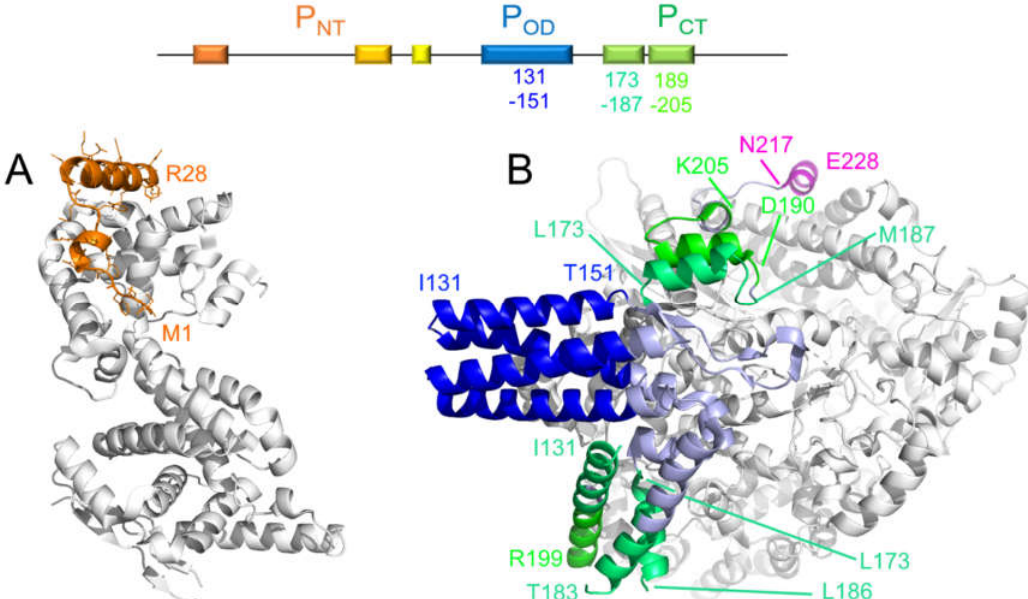
Figure 6. Folding of Pneumoviridae P protein upon binding to N 0 and L proteins. ( A ) X-ray crystal structure of the hMPV N 0 –P complex, with stabilization of a transient N -terminal helix of P (PDB code 5FVD) [60]. ( B ) Structural model of the RSV L–P complex determined by cryogenic electron microscopy at a 3.2 Å resolution (PDB 6PZK) [32]. A similar structural organization was observed in a second cryo-EM structure of the RSV L–P complex at a 3.67 Å resolution (PDB 6UEN) [33] as well as in an hMPV L–P complex at a 3.8 Å resolution (PDB 6U5O) [34]. The partner proteins, N 0 and L, are represented in white cartoon. The P fragments are shown in cartoon and in color. The color code for the complexed P helices is indicated in the scheme on top of the figure. In the L–P complex, the regions located between the tetramerization domain and the C -terminal transient helices predicted by NMR are shown in pale blue. The C -terminal helix N217-E228, which has no α-helical propensity in free P, is shown in magenta. The precise topology of each P protomer is indicated in Figure 2.